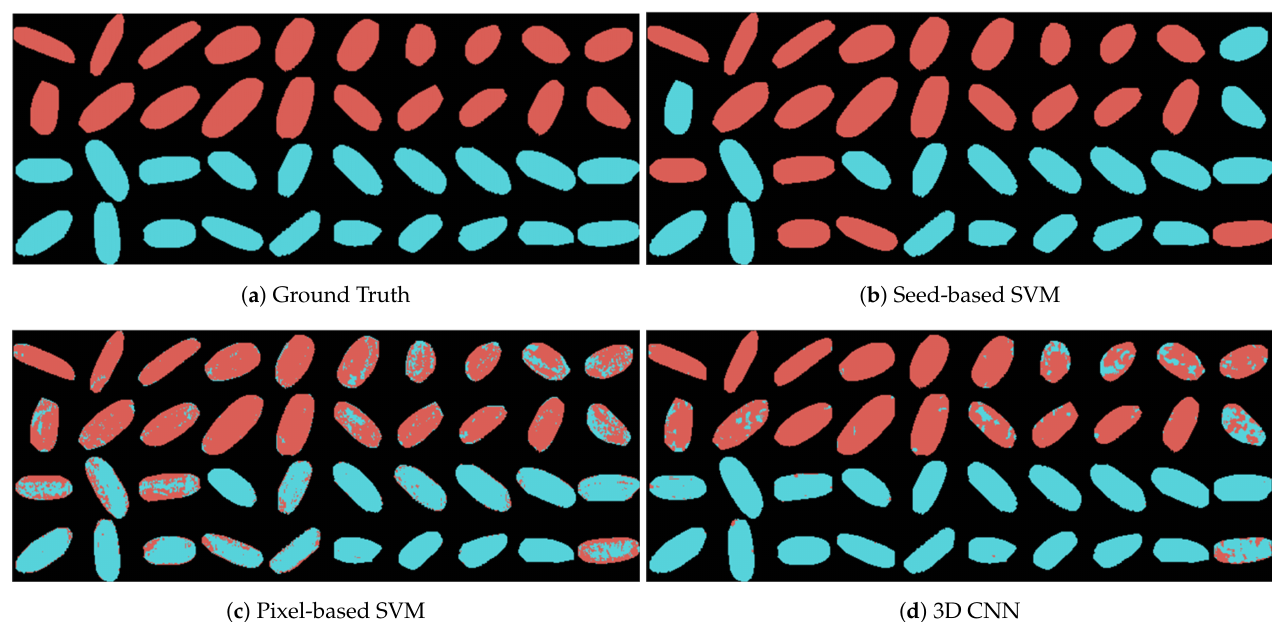
Figure 8. The ground truth and the predicted results using different models: ( a ) the ground truth; ( b ) the seed-based prediction results using SVM; ( c ) the pixel-based prediction results using SVM; and ( d ) the pixel-based prediction results using 3D